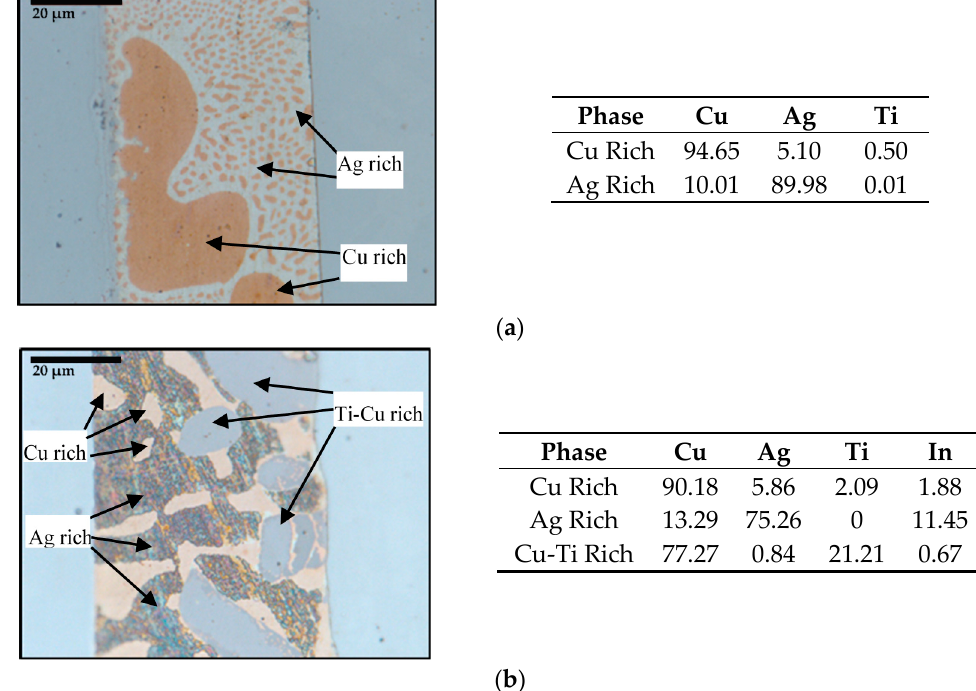
Figure 4. Optical image of a Cu-Ag-Ti braze ( a ) and Cu-Ag-In-Ti braze ( b ) with labeled markers indicating the microconstituent phases present. Tables to the right of each image present average atomic % for each phase in ( a ) and ( b ), respectively, calculated from EDS data.